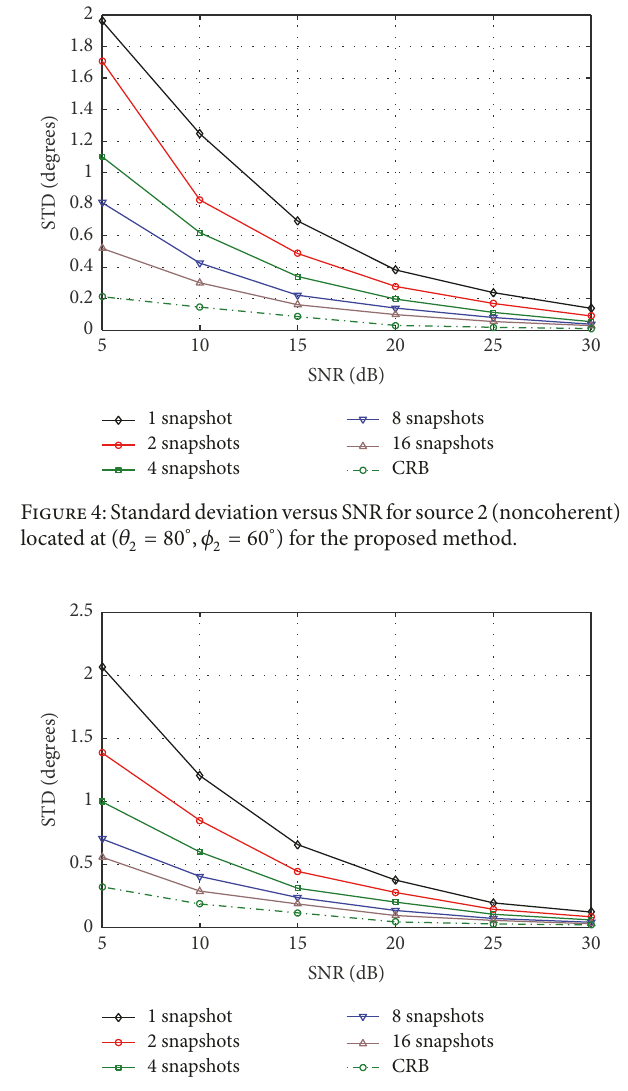
Figure 5: Standard deviation versus SNR for source 1 (coherent) located at (𝜃 1 = 70 ∘ ,𝜙 1 = 50 ∘ ) for the proposed